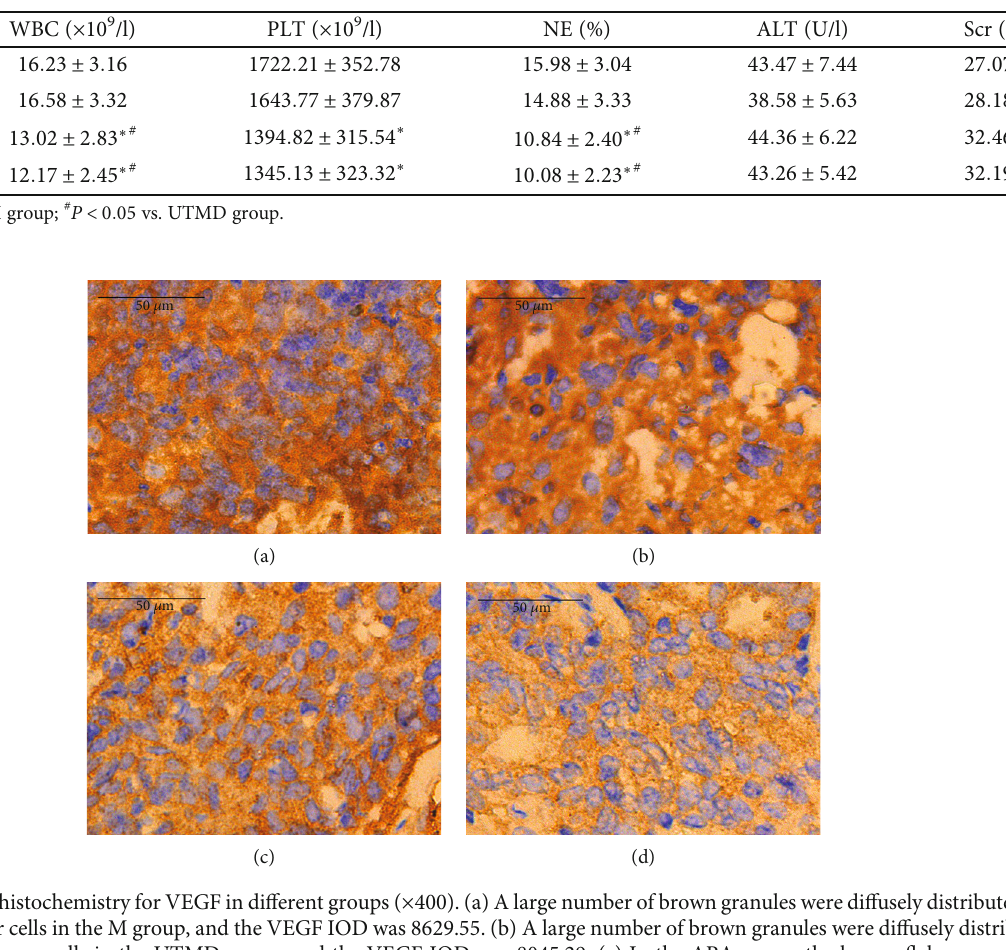
Table 3: Blood parameters after treatments in di ff erent groups ( n = 10 , (cid:1) x ± SD ).